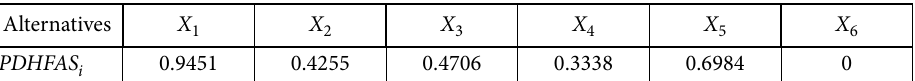
Table 13. The PDHFAS i value Alternatives X 1